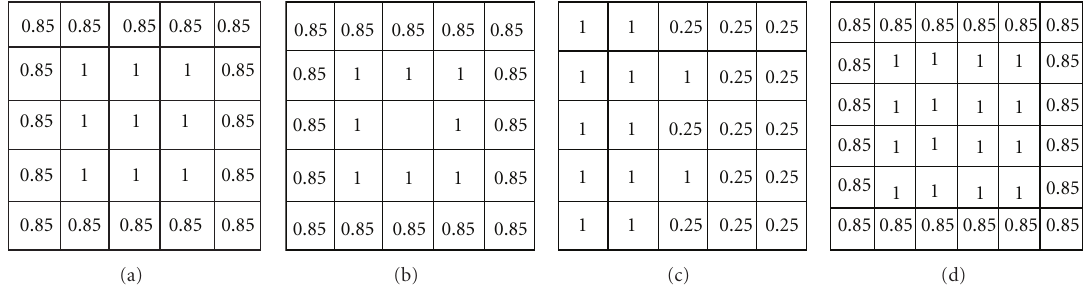
Figure 2: Radial power profiles used in the experiments [1]. Table 2: Bundle parameters